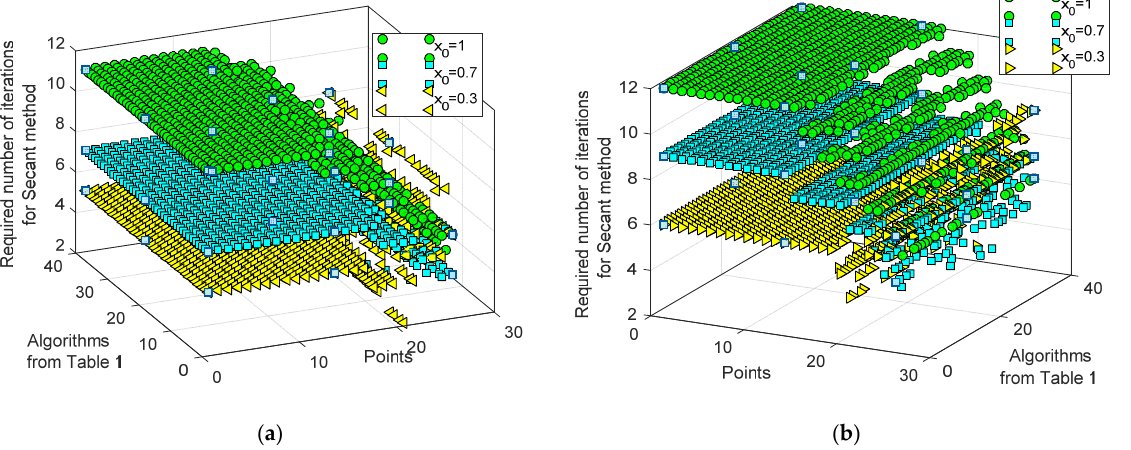
Figure 5. Required number of iterations for all voltage values with different stopping criteria using SM: ( a ) 10 − 5 ; ( b ) 10 − 10 .